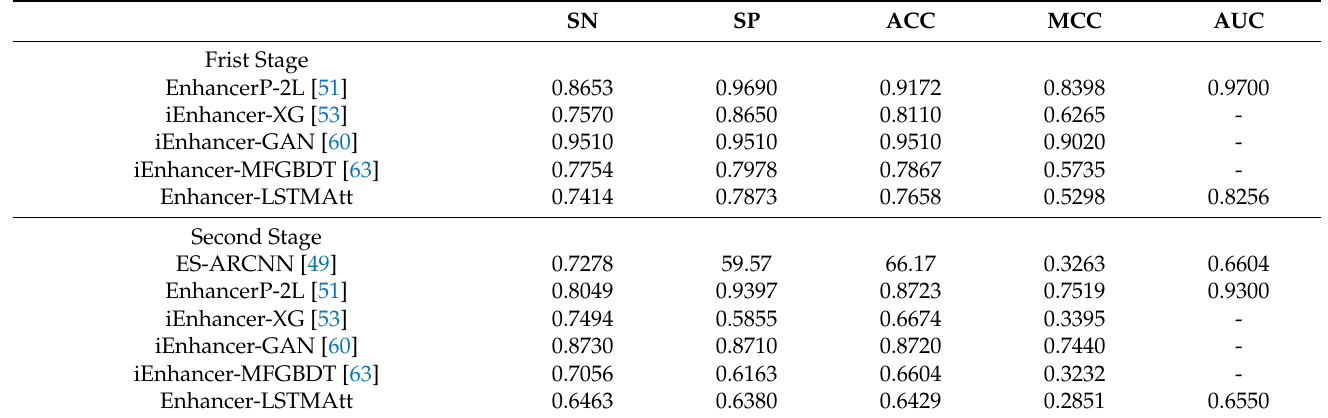
Table 5. Comparison with state-of-the-art methods by 10-fold cross validation.